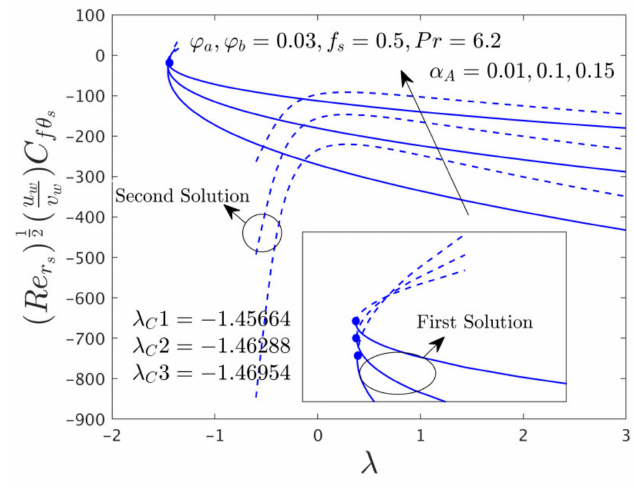
(cid:16) (cid:17) u w C f θ versus λ for numerous choices of α A . v w s s